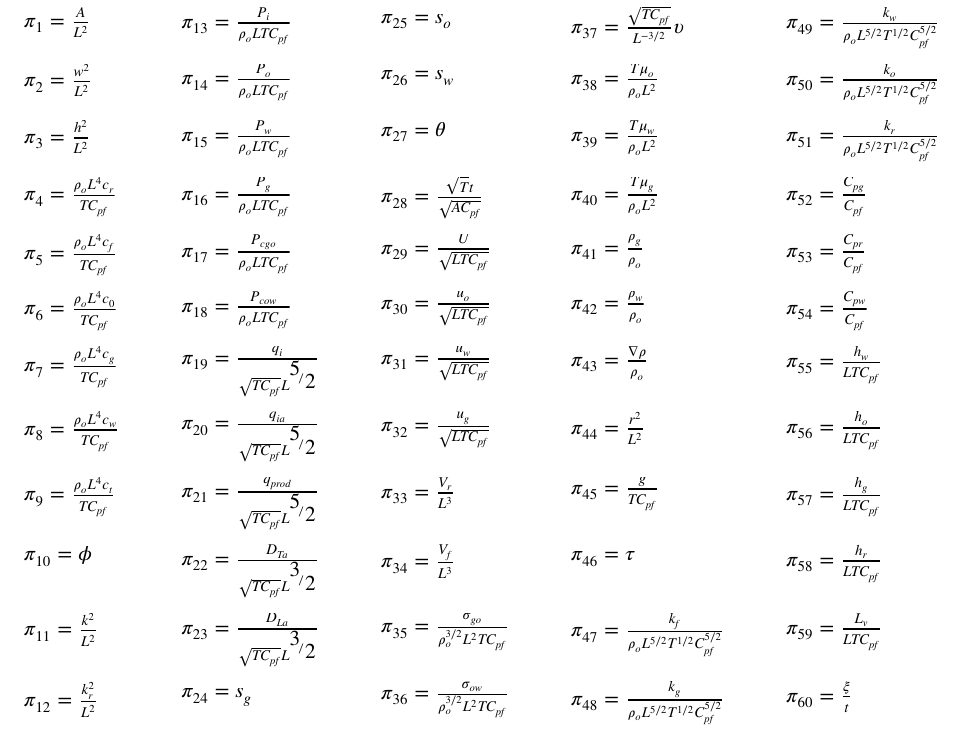
from dimensional